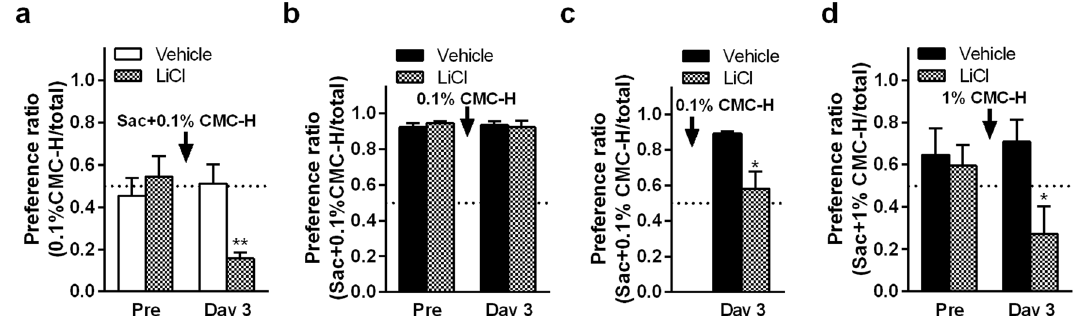
Figure 5. Effect of sweet taste on viscosity discrimination. Mean ± standard error of the mean. ( a ) Following short pre-exposure to high-viscosity carboxymethyl cellulose (CMC)-containing fluids (CMC-H) with baseline value measurements, preference ratio in water and 0.1% CMC-H after lithium chloride (LiCl) injection following ingestion of saccharin-containing 0.1% CMC-H fluid (Sac + 0.1% CMC-H) as conditioned stimulus (CS) (each group, n = 5). ( b , c ) Preference ratio in water and Sac + 0.1% CMC-H fluid after LiCl injection following ingestion of 0.1% CMC-H as CS with or without short pre-exposure, respectively (each group, n = 5). ( d ) Preference ratio in water and Sac + 1% CMC-H fluid after LiCl injection following ingestion of 1% CMC-H as CS with short pre-exposure (each group, n = 5). * and **, P < 0.05 and 0.01, respectively, against vehicle on the same tested day by unpaired two-tailed Student’s t